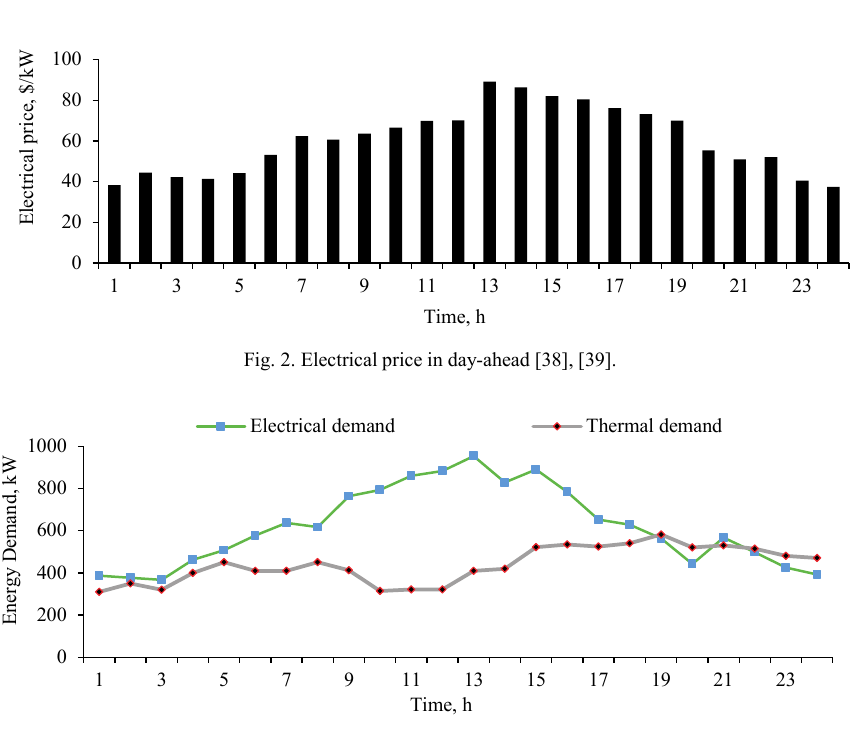
Fig. 3. Electrical and thermal